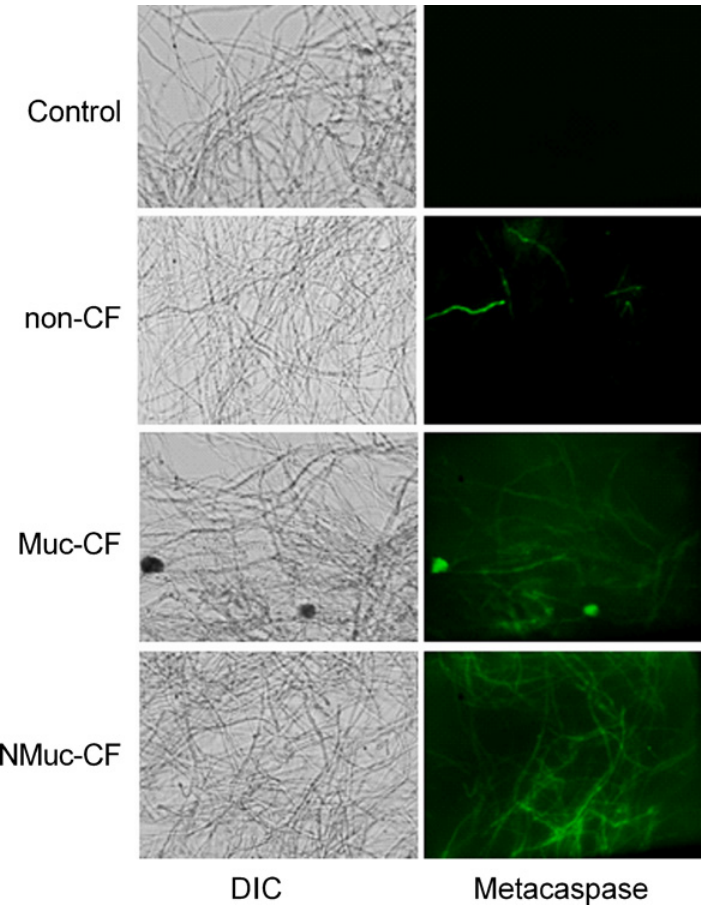
Fig 6. A . fumigatus preformed biofilms treated with P . aeruginosa biofilm culture filtrates activates caspase-like (metacaspase) activity. Fluorescent images depicting metacaspase activation of preformed A . fumigatus biofilm treated with culture filtrates of non-CF, Muc-CF, and NMuc-CF P . aeruginosa , as detected by staining with CaspACE FITC-VAD-FMK. DIC: differential interference